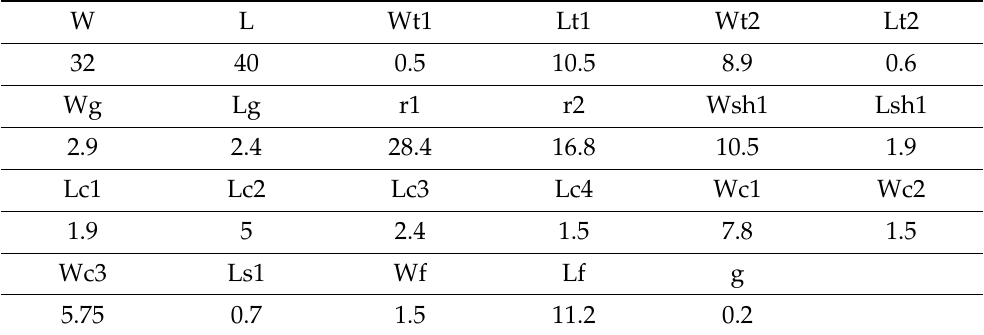
Figure 1. Proposed antenna structure. Table 1. Antenna parameters (unit: mm).